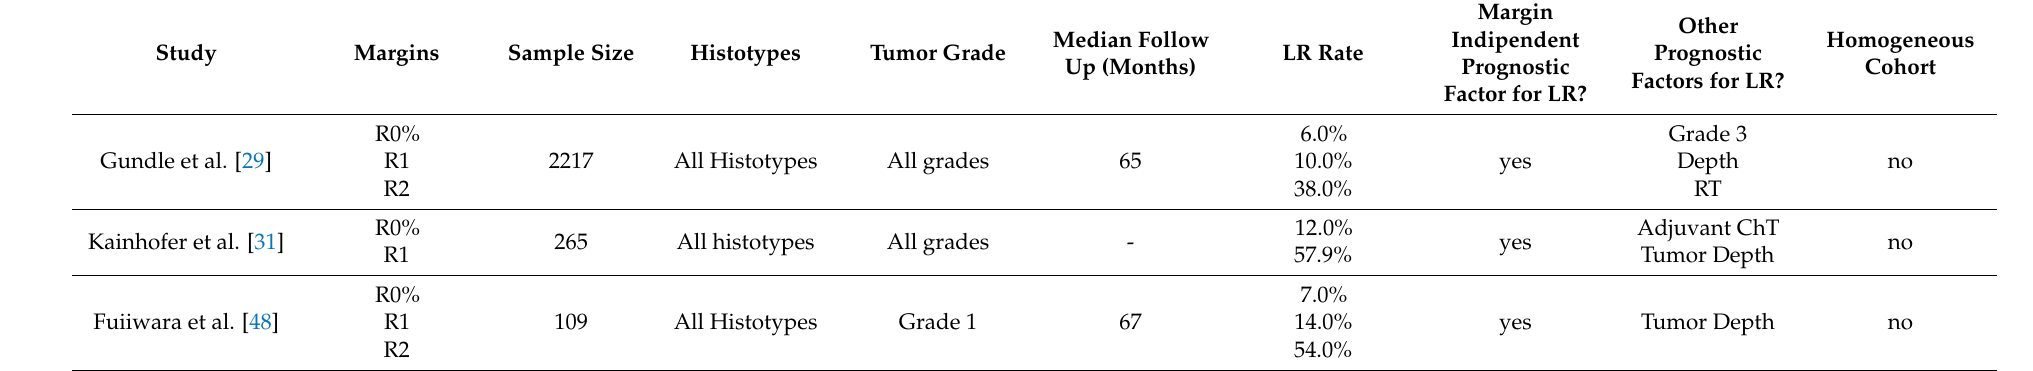
Table 4. Review of the literature. Studies reporting margins based on UICC classification.